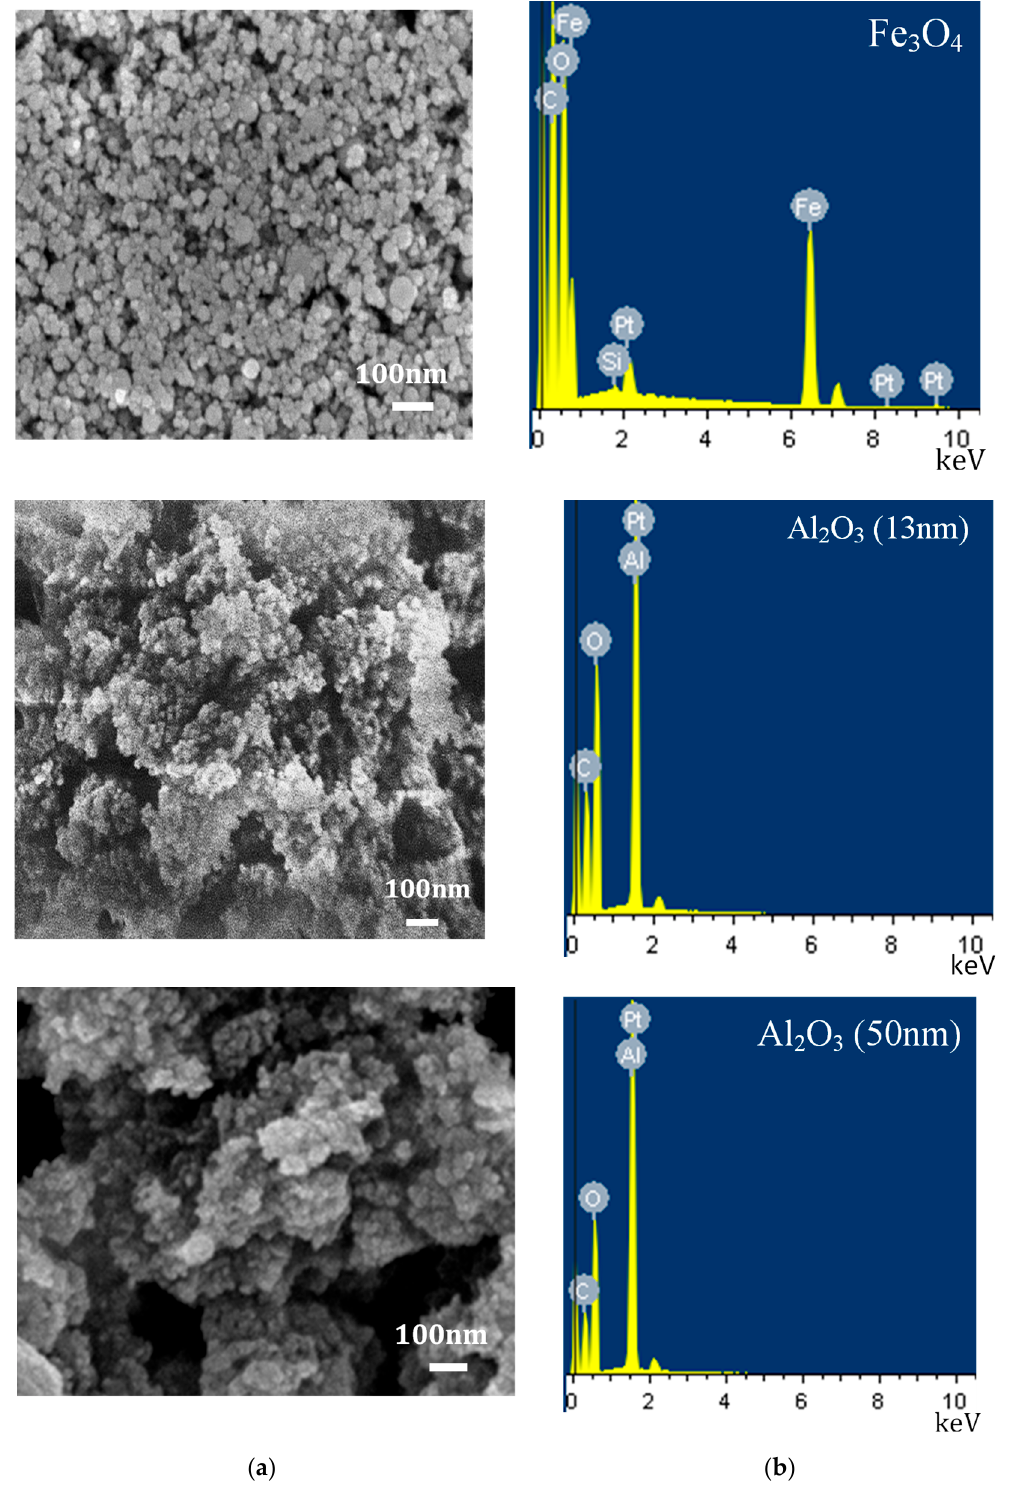
Figure 2. ( a ) Scanning electron microscope (SEM) and ( b ) EDS images of nanoparticles.